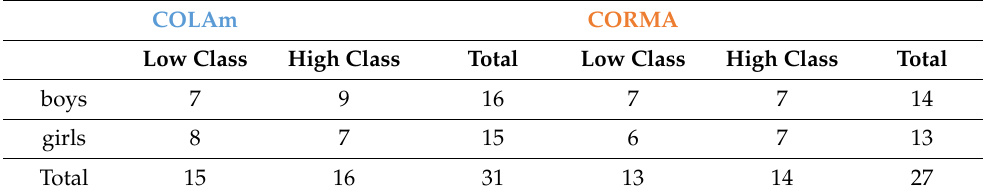
Table 1. Sociolinguistic distribution of speakers in COLAm and